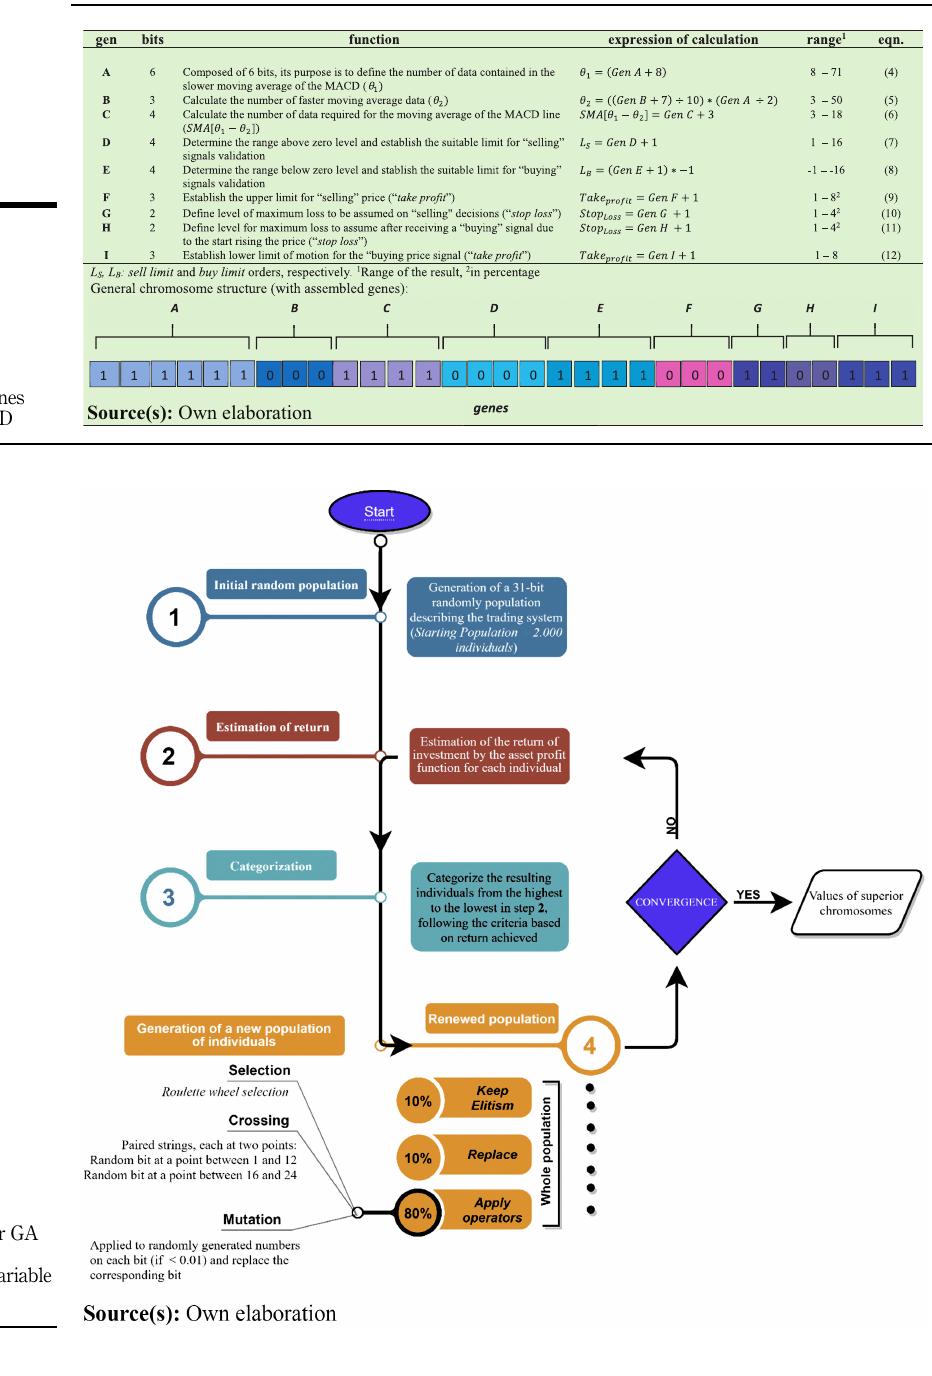
Figure 1. Methodology for GA optimization of investment in